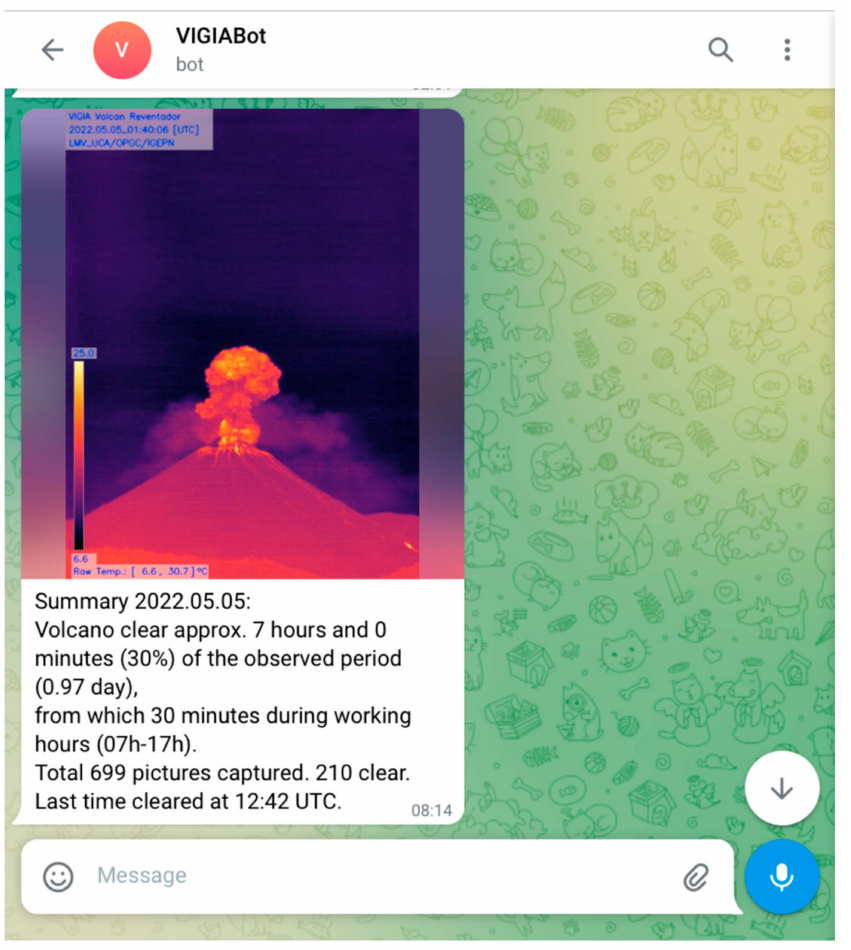
Figure 7. By using a telegram bot, VIGIA sends a daily report with statistics of the day based on the volcano recognition. The picture of the day is the one where the volcano was unclouded and the quality factor is the highest.